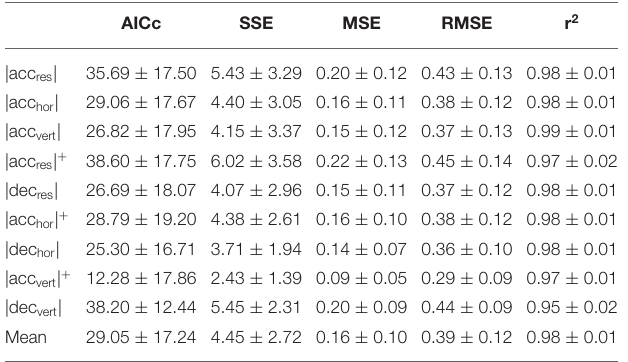
TABLE 1 | Evaluation of the fitting model representing the relationship between peak median acceleration (y) and time duration (t dur ; x) for every player and game tested in the study.